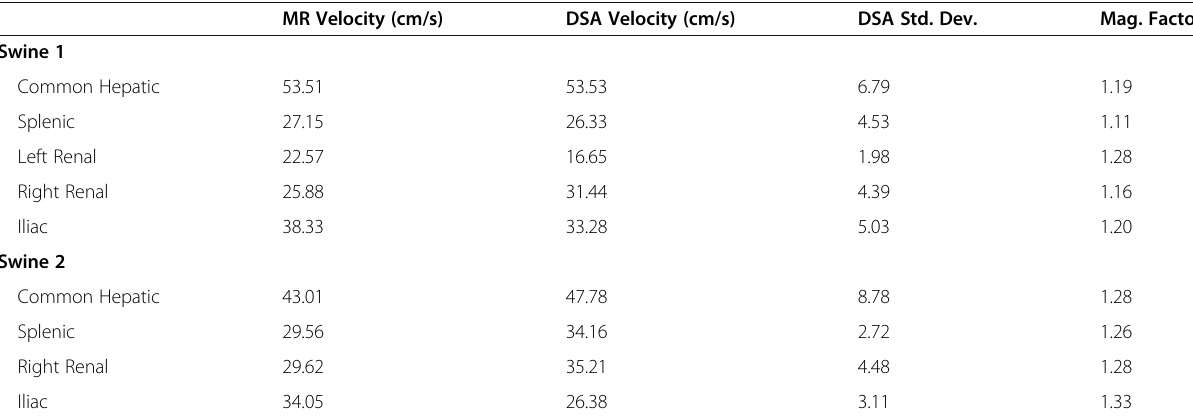
Quantitative values from the in vivo study for both imaging modalities are presented in the table. The standard deviation of the DSA velocity is provided from the triplicate scans. The magnification factor was calculated for each vessel by imaging a reference wire, of 3cm in length, in the vessel of interest prior to injection